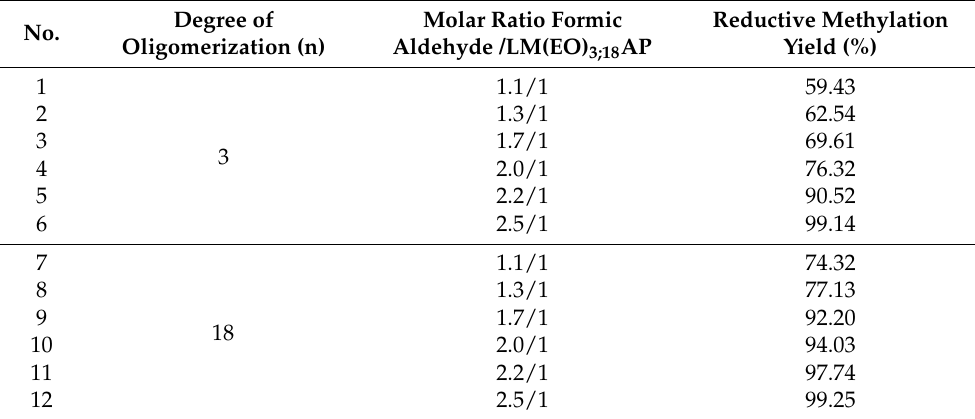
Table 3. The dependence of the reductive methylation yield of LM(EO) 3;18 AP on the molar ratio formic aldehyde/LM(EO) 3;18 AP, reaction time 50 min, molar ratio formic acid/LM(EO) 3;18 AP 5/1, and temperature 70 ◦